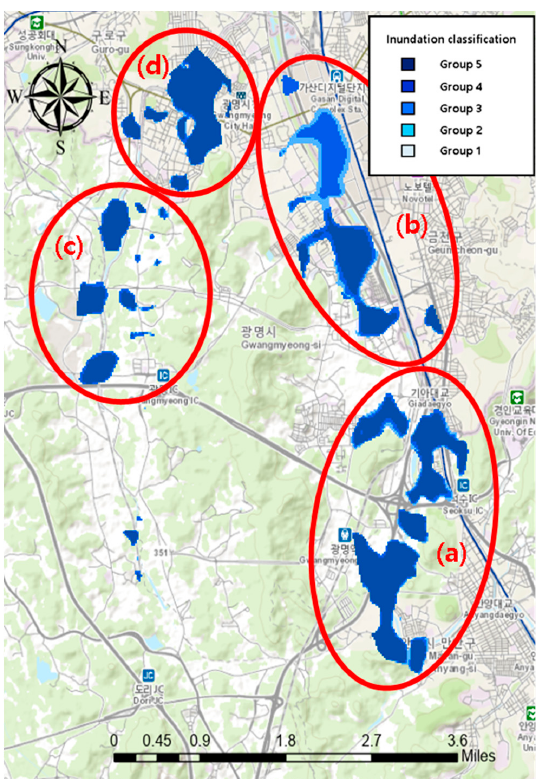
Figure 5. Inundation zone of two streams: each stream showed two inundation zones (Anyangcheon main stream: ( a , b ) / Mokgamcheon stream: ( c , d )); Each zone is consist of 5 inundation groups according main stream: (( a ),( b ))/Mokgamcheon stream: (( c ),( d ))); Each zone is consist of 5 inundation groups according to water level (h) (Group 1: 0m (cid:3409) h (cid:3409) 0.5m , Group 2: 0.5m (cid:3407) h (cid:3409) 1.0m , Group 3: 1.0m (cid:3407) to water level (h) (Group 1: 0 m ≤ h ≤ 0.5 m, Group 2: 0.5 m < h ≤ 1.0 m, Group 3: 1.0 m < h ≤ 2.0 m, h (cid:3409) 2.0m , Group 4: 2.0m (cid:3407) h (cid:3409) 3.0m , Group 5: 3.0m (cid:3407) h: ). Group 4: 2.0 m < h ≤ 3.0 m, Group 5: 3.0 m <